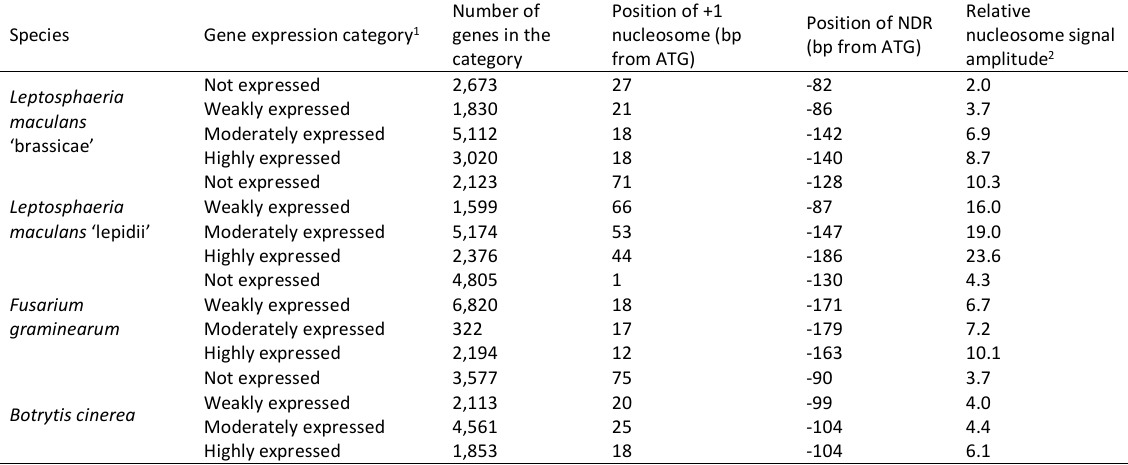
Supplementary Table 6. Nucleosome landscapes as a function of gene expression defining metrics